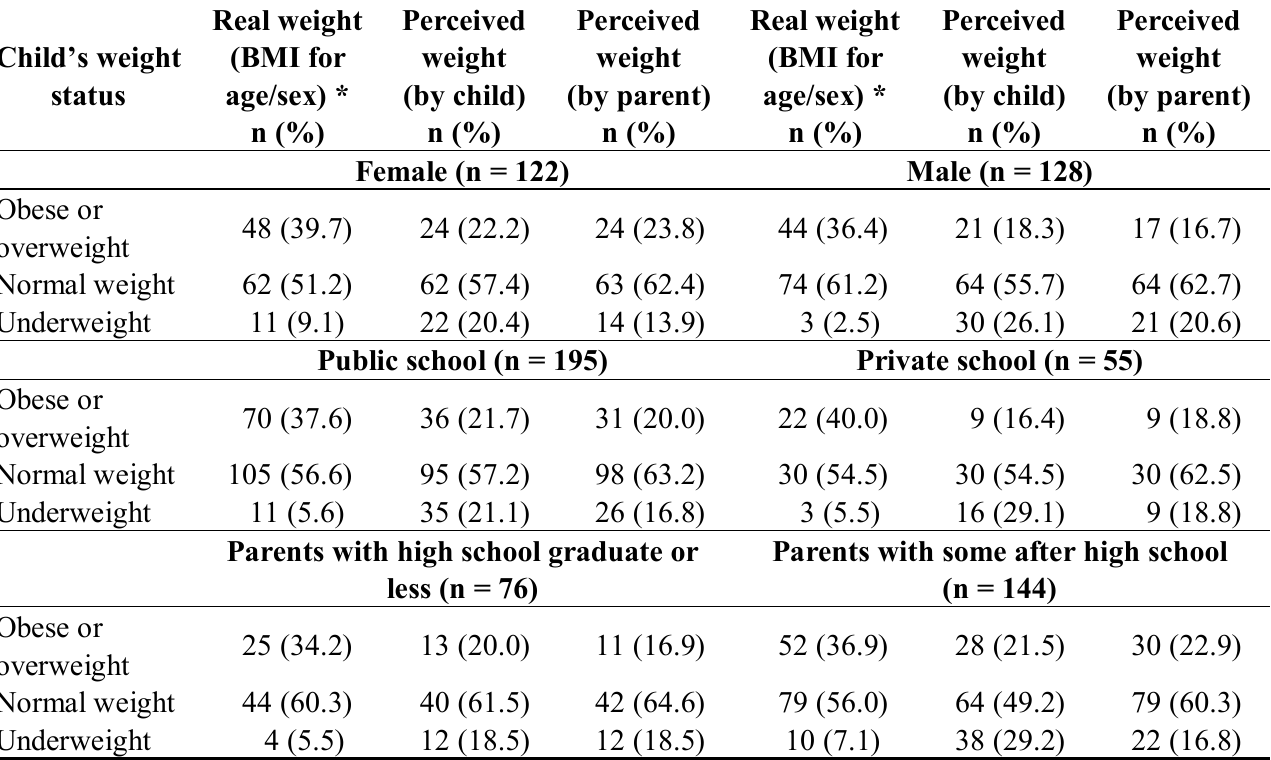
Table 2. Estimates of Real and Perceived Weight Status by Child’s Gender, School Type, and Parent’s Educational Level among Elementary School Students, Cayey, Puerto Rico, 2008